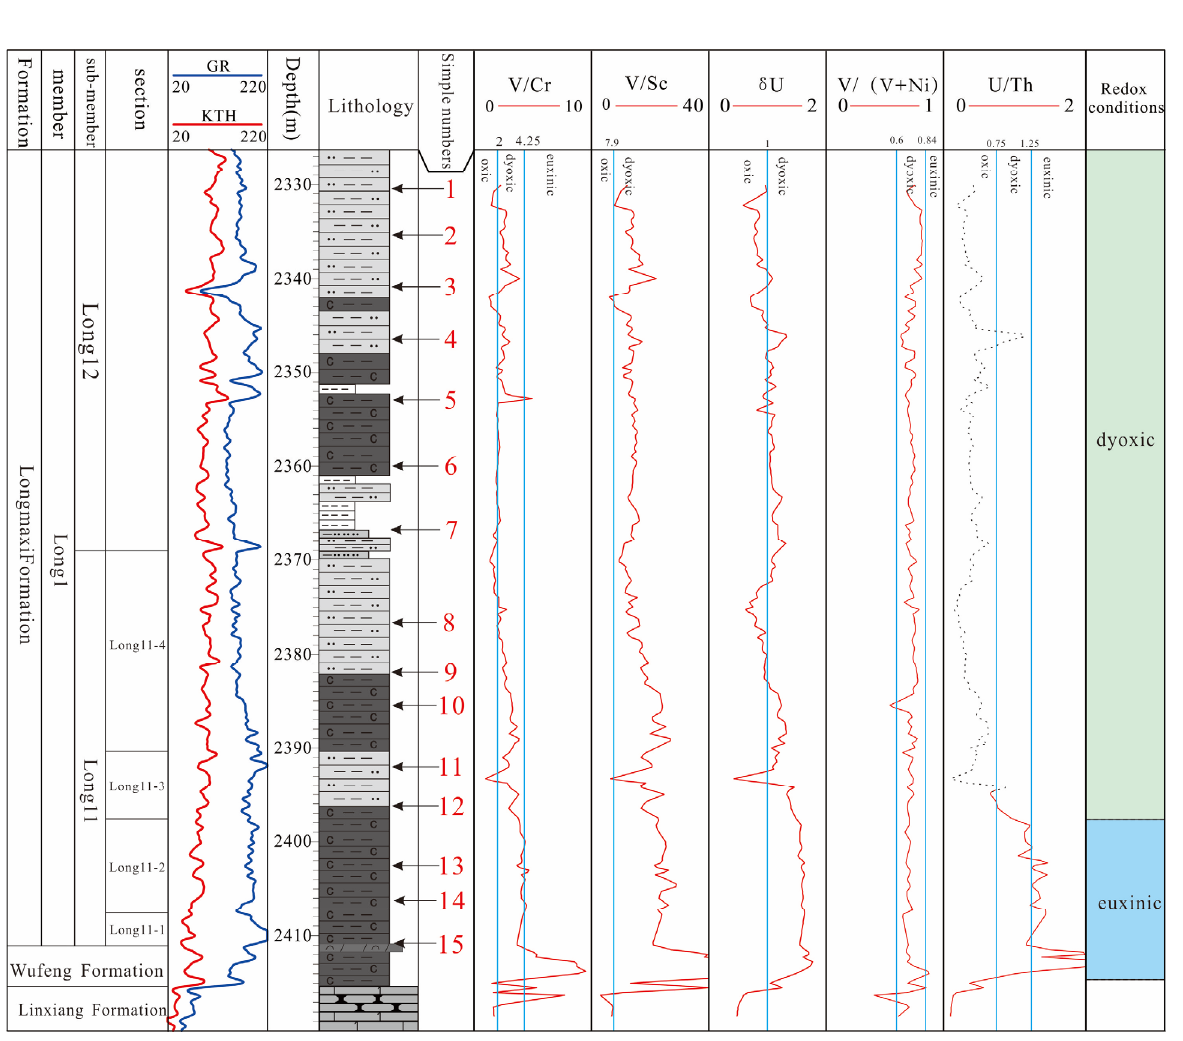
Figure 9. The redox condition variations in the Wufeng–Longmaxi marine shale of the JY1 well in the Jiaoshiba area, southeast Sichuan Basin.